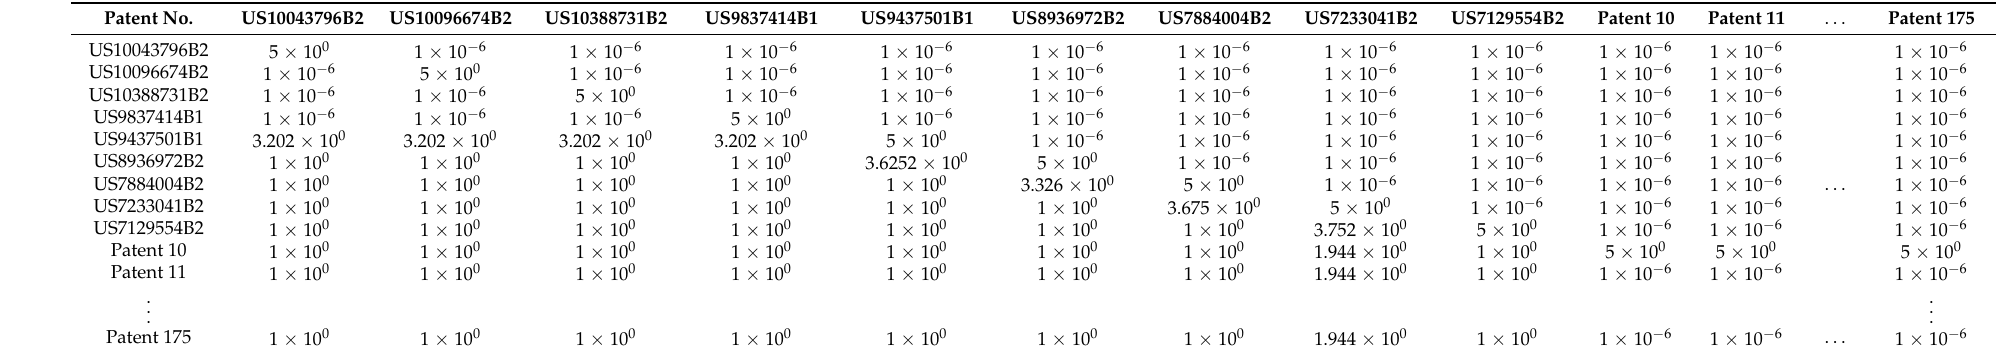
Table 8. The matrix A d of the second empirical case.